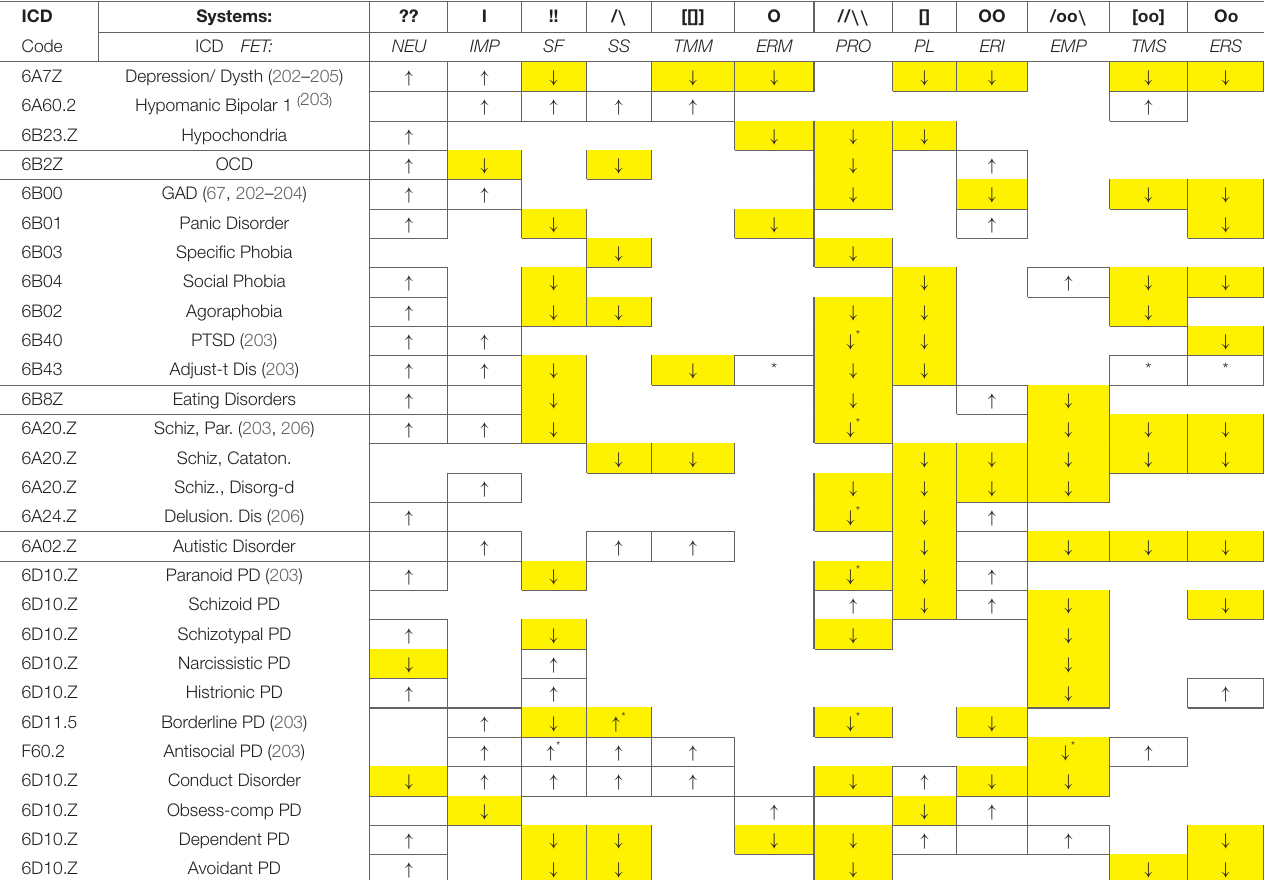
TABLE 3 | Proposed correspondence between described neurochemical systems, temperament traits of the FET model and main diagnoses of psychopathology. ICD